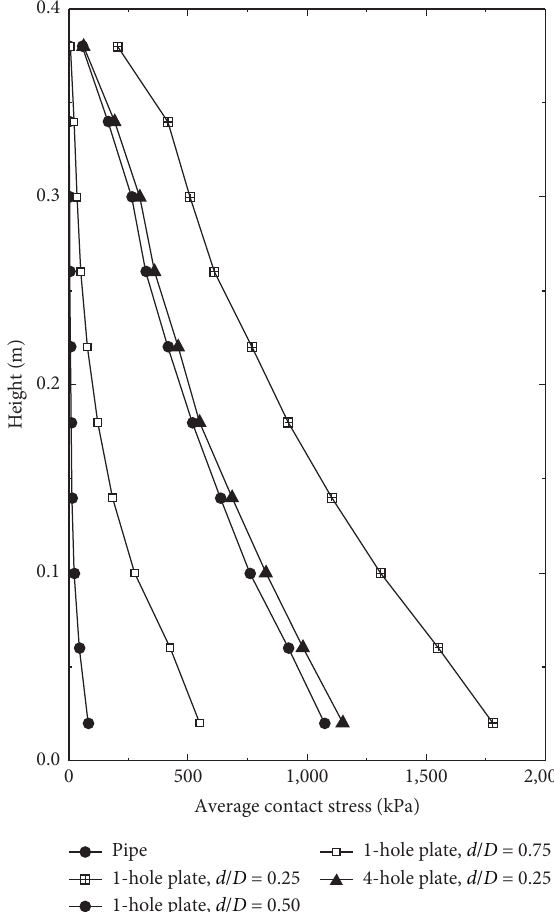
Figure 14: Average particle contact stress inside the soil plug over heights ( D � 10cm and L / D �